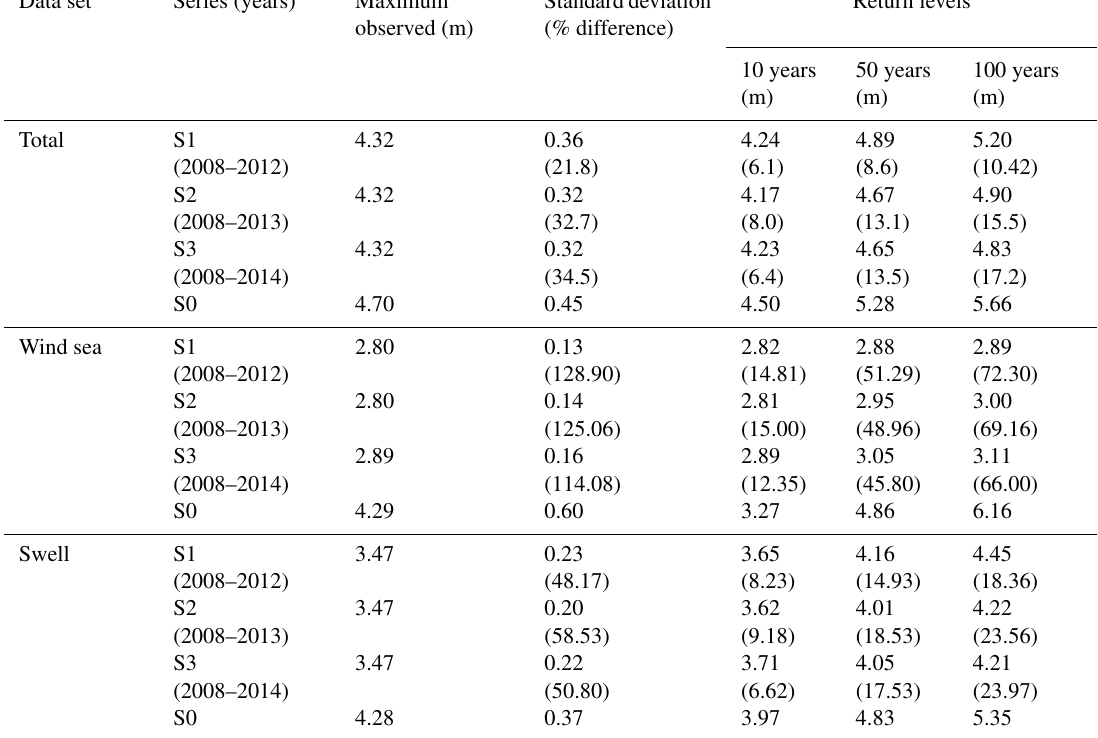
Table 6. Table showing the results of the case study. The standard deviations (SDs) of each data series considered are provided, and percentage differences among the SDs of each series with parent series (S0) are given in the brackets. The percentage difference in the corresponding return level estimation is also shown in the brackets of the respective return